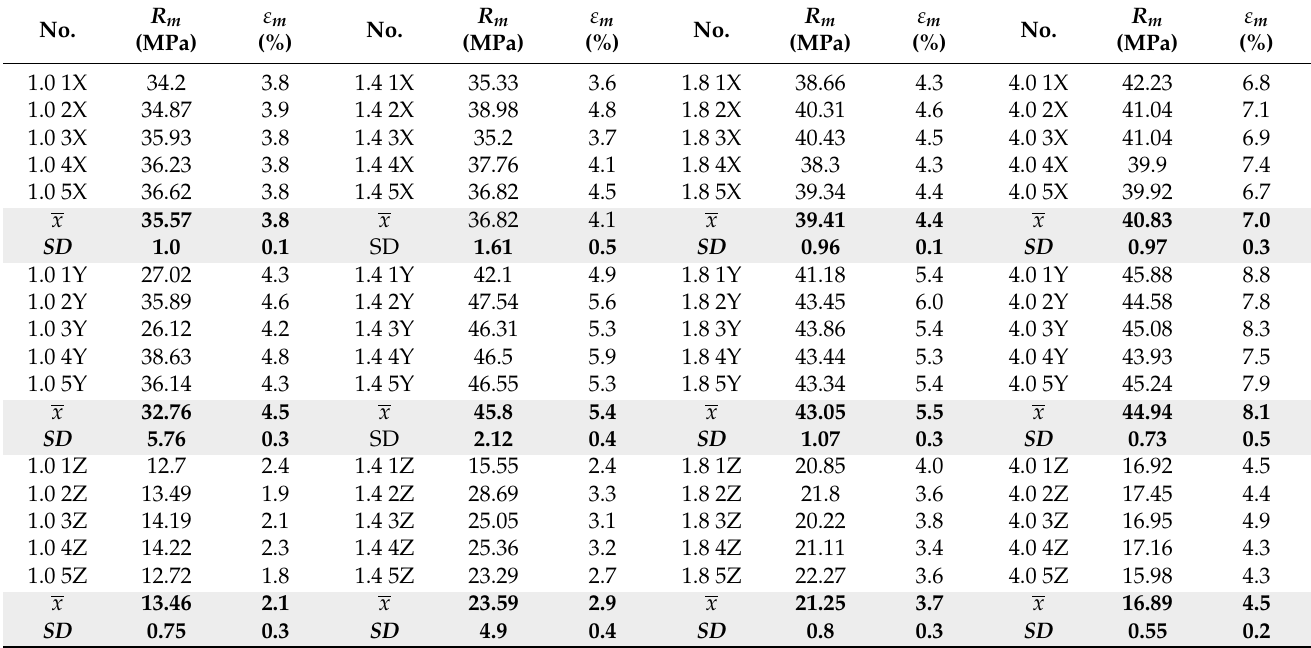
Table 4. Ultimate tensile strength and the maximum percentage deformation for the PLA specimens.